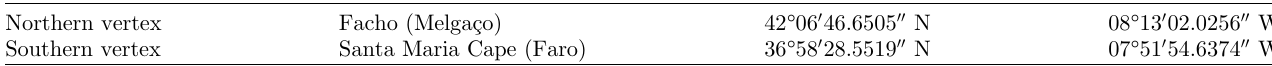
Table 2. Upper and lower parallels of the LCC map projection for mainland Portugal.